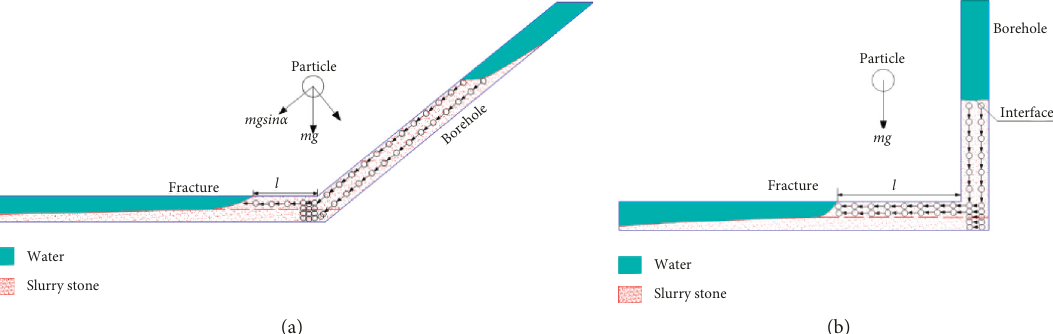
Figure 7: Mechanical mechanism of particle gravity deposition in the second gravity deposition of the (a) inclined borehole and (b) vertical borehole.